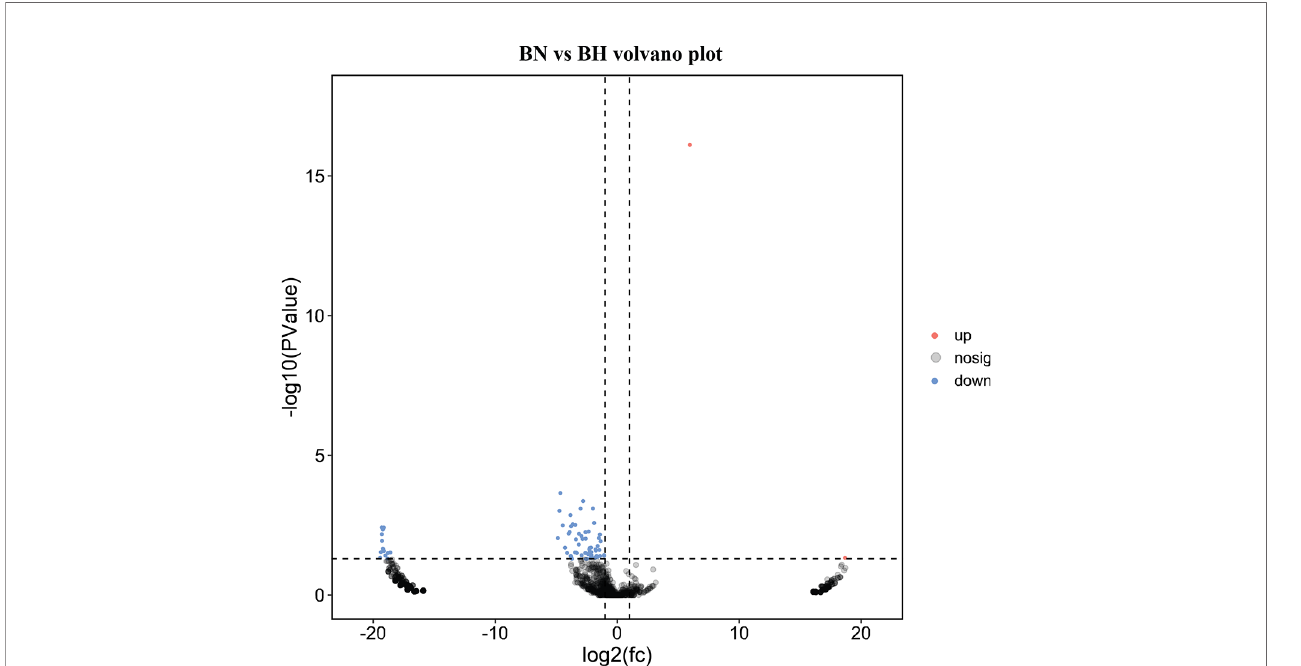
FIGURE 2 | Volcano plot of differentially expressed circular RNAs (DEcircRNAs) between blind-side normal (BN) and blind-side hypermelanotic (BH) groups in tongue